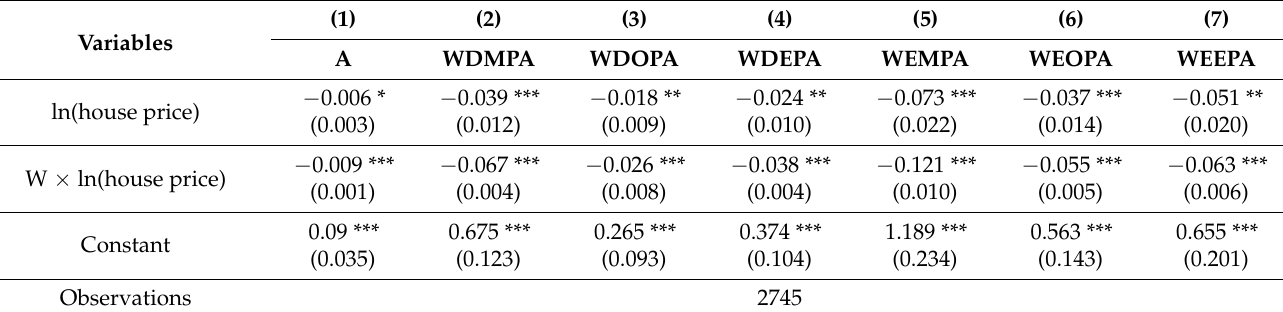
Table 3. Spatial Durbin model of medical accessibility and house price. A, overall medical service accessibility; WDMPA, weekday morning peak accessibility; WDOPA, weekday off-peak accessibility; WDEPA, weekday evening peak accessibility; WEMPA, weekend morning peak accessibility; WEOPA, weekend off-peak accessibility; WEEPA, weekend evening peak accessibility.